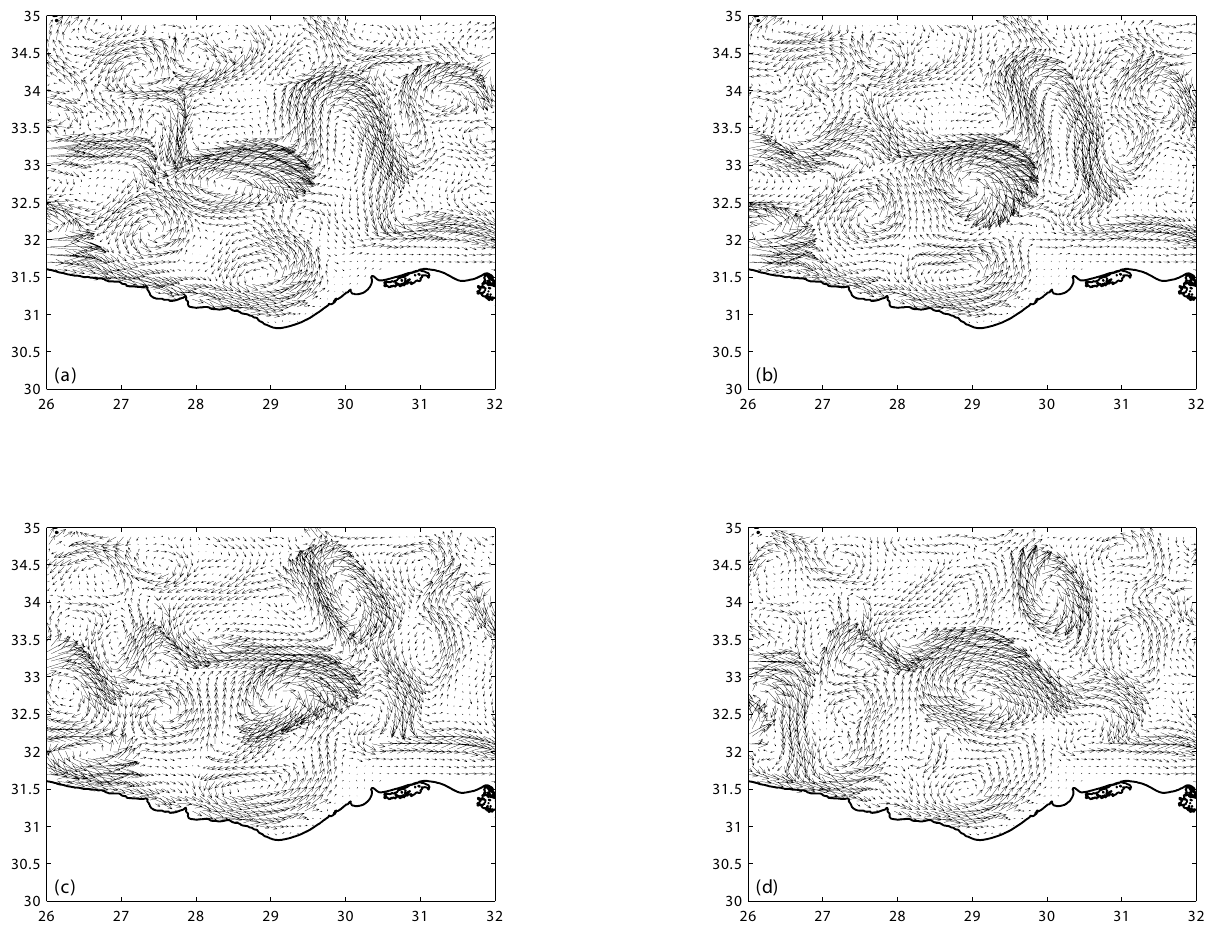
Fig. 13. Evolution of ALERMO’s subsurface (30m) velocity field within the geographical area 30 ◦ –35 ◦ N, 26 ◦ –32 ◦ E for (a) 20 January (b) 30 January (c) 10 February and (d) 20 February.